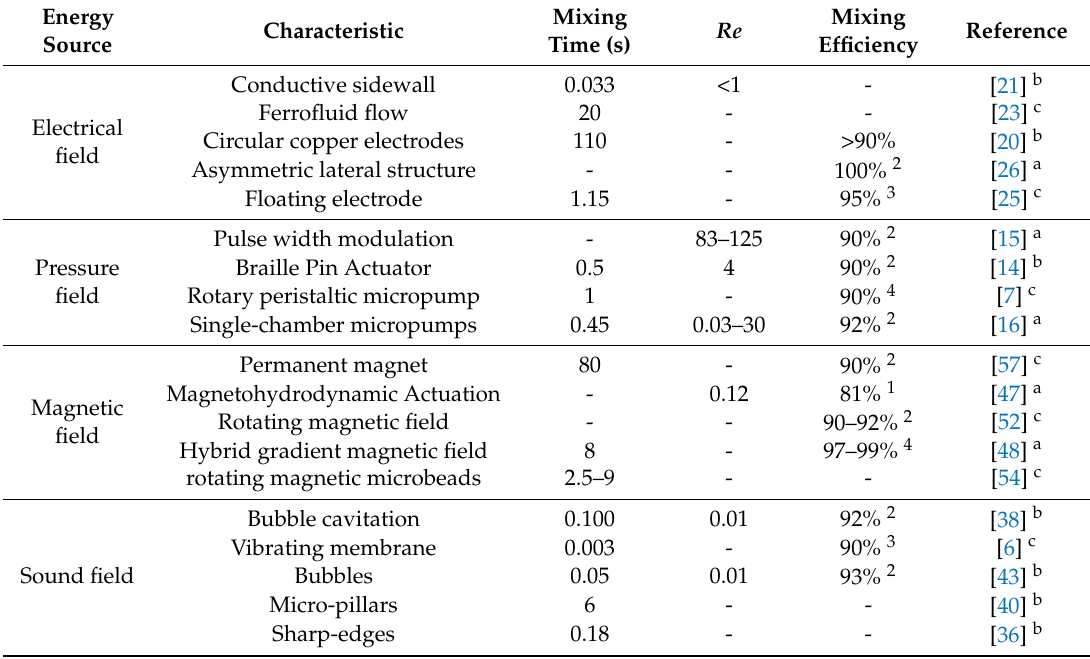
Table 1. Active micromixers reported in recent five